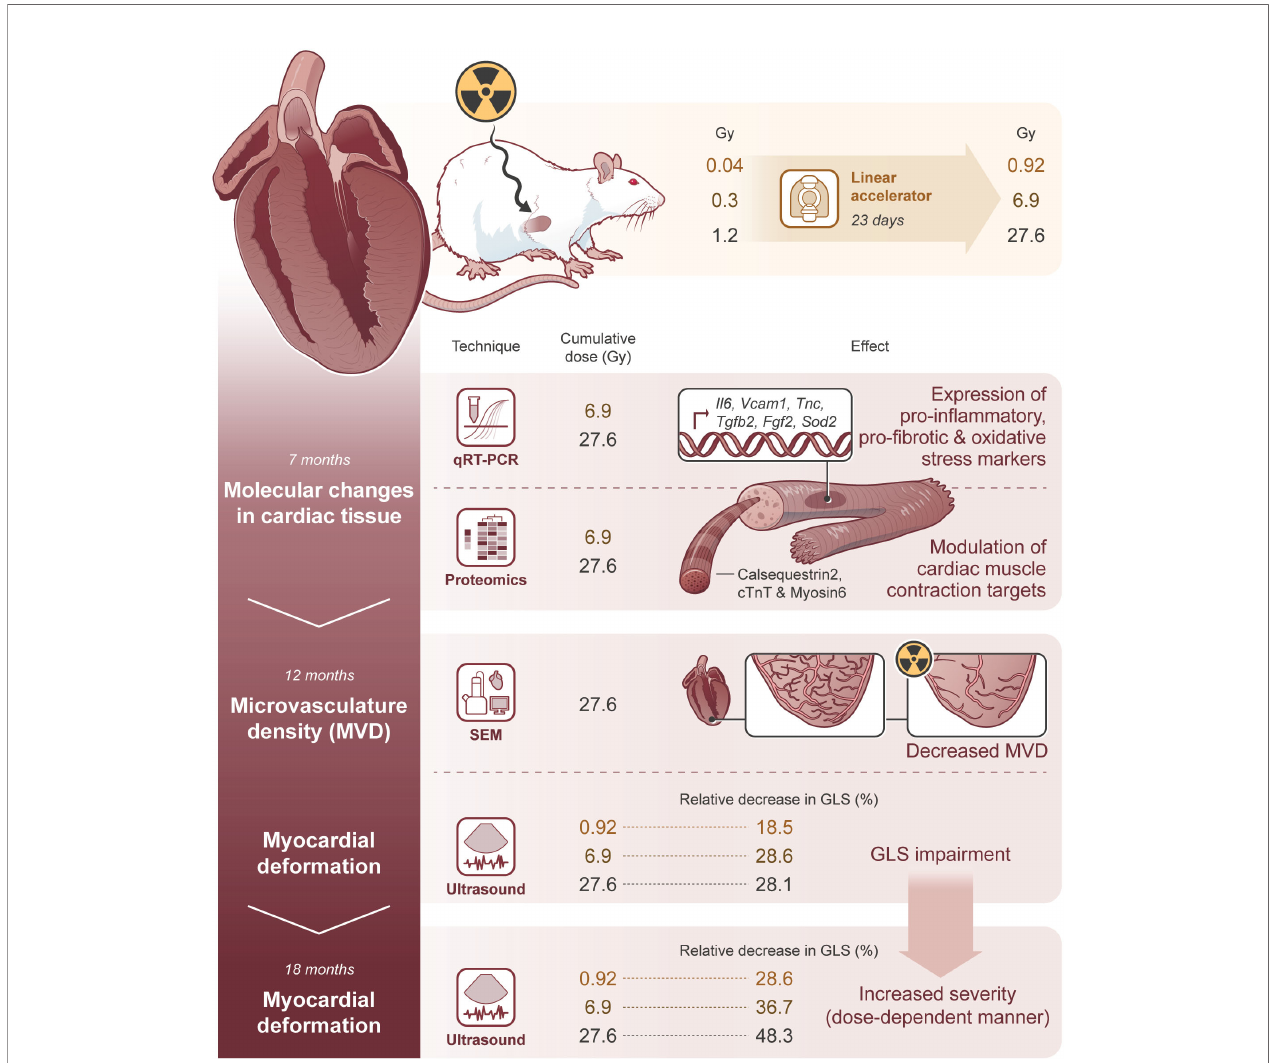
FIGURE 8 | Molecular changes in cardiac tissue precede microvasculature density decrease and GLS impairment, affecting its severity in a dose-dependent manner. The illustrative fi gure summarizes the main conclusions of this study. Rat hearts were exposed to daily doses of 0.04, 0.3, and 1.2 Gy, achieving cumulative doses of 0.92, 6.9, and 27.6 Gy, respectively to evaluate the contribution of radiotherapy, per se , in late cardiotoxicity. At 7 months after the end of IR exposure, the cardiac tissue was modulated as demonstrated by the number/expression of several genes and proteins related to in fl ammation, fi brosis, and cardiac muscle contraction, differently expressed according to the cumulative dose. Importantly, the molecular changes in cardiac tissue precede microvascular density decrease and myocardial deformation, which are not observed until 12 months after the end of IR exposure. Later, at 18 months, the severity of GLS impairment is increased, demonstrating a myocardial deformation in a dose-dependent